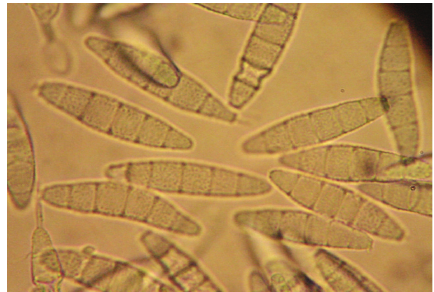
Figure 2: Septate conidia of Trichophyton ajelloi from fungal blepharitis from Figure 1 ×